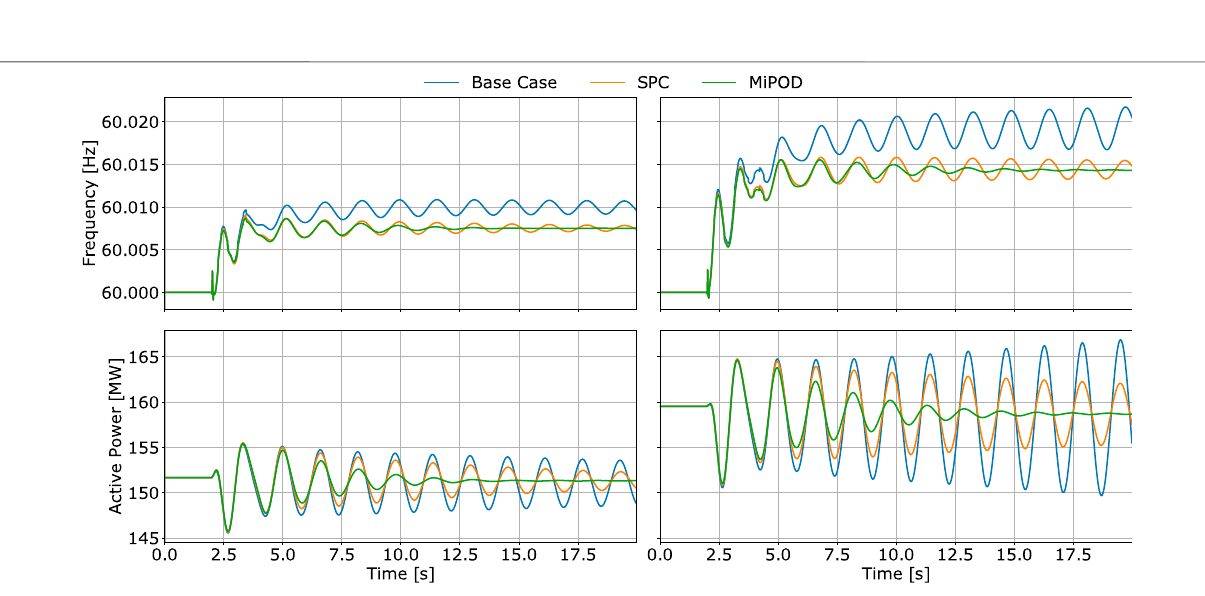
Frontiers in Energy Research |